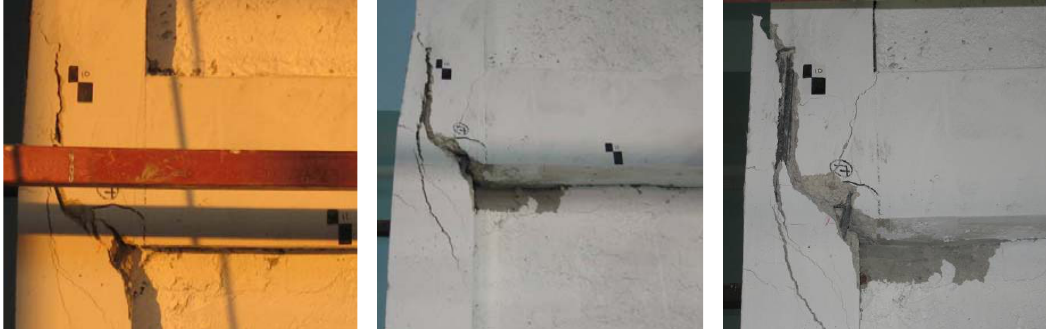
Fig. 14. Failure of the left beam-column joint.